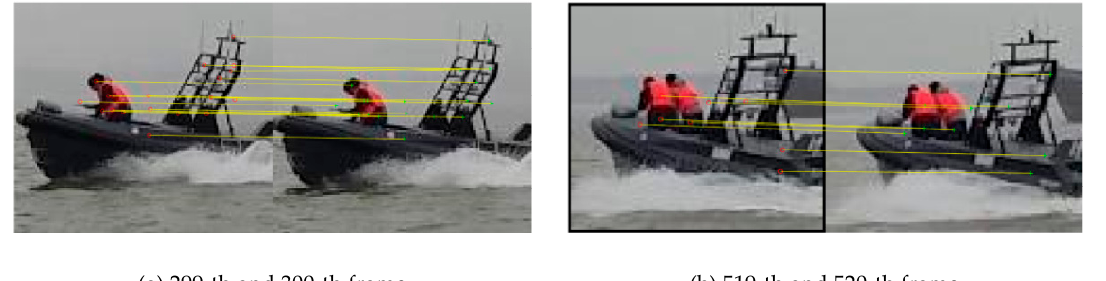
Figure 7. Schematic diagram of matching points based on surf feature in adjacent frames: ( a ) 299-th and 300-th frame; ( b ) 519-th and 520-th frame.